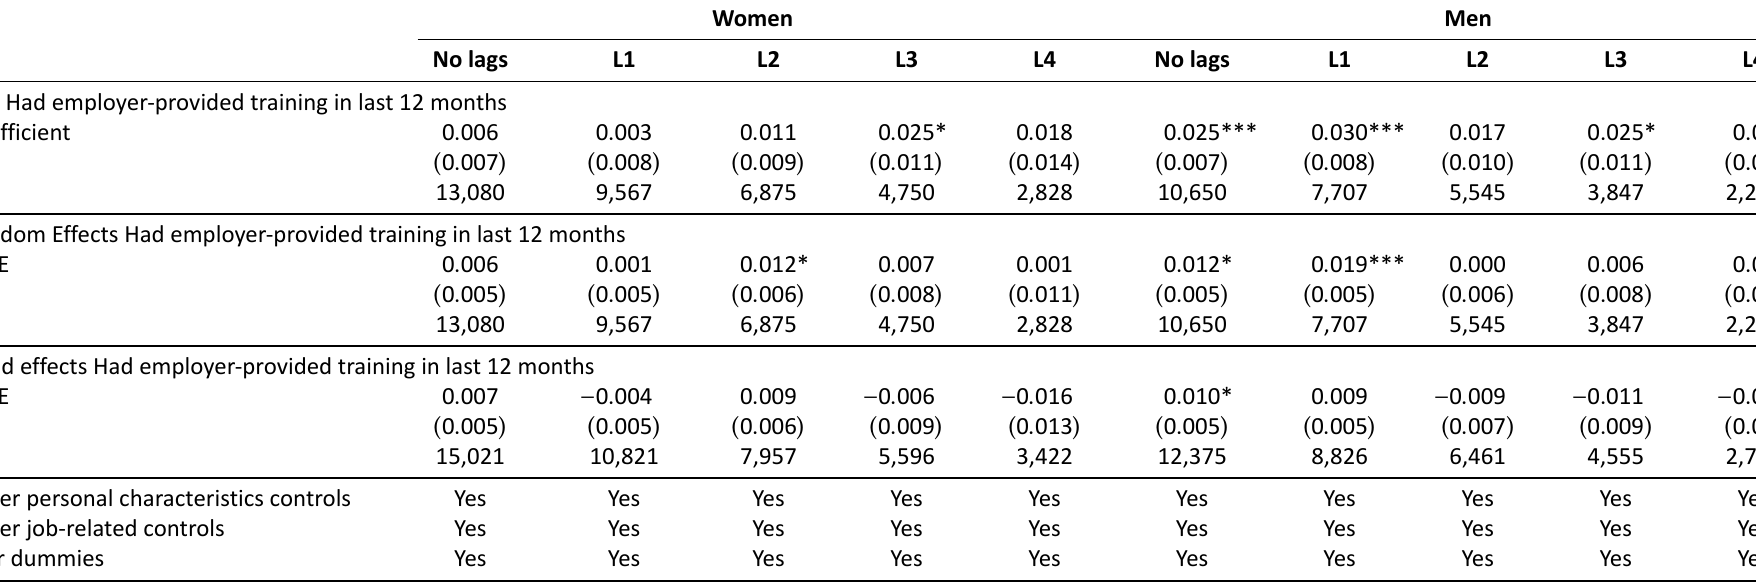
Table 2. Association between doing training in the last 12 months and wages, various lags.